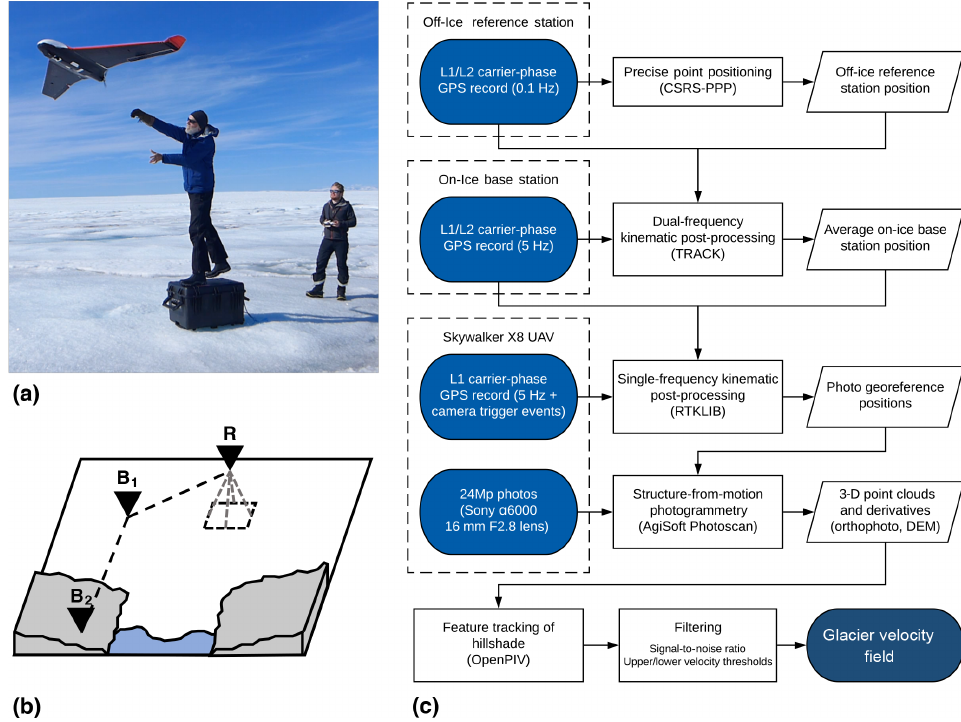
Figure 2. The method used in this study: (a) launching the Skywalker X8 on the ice sheet; (b) cartoon visualizing the relationship of kinematic GPS corrections among the UAV rover (R), on-ice launch site base station (B 1 ), and the off-ice reference station (B 2 ); and (c) flow chart showing the workflow used in this study to derive photogrammetry products and velocity fields at the inland study site.